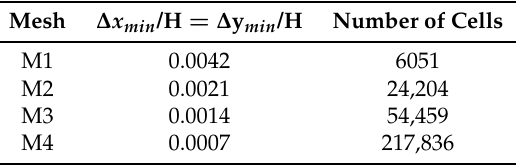
Table 1. Mesh characteristics.